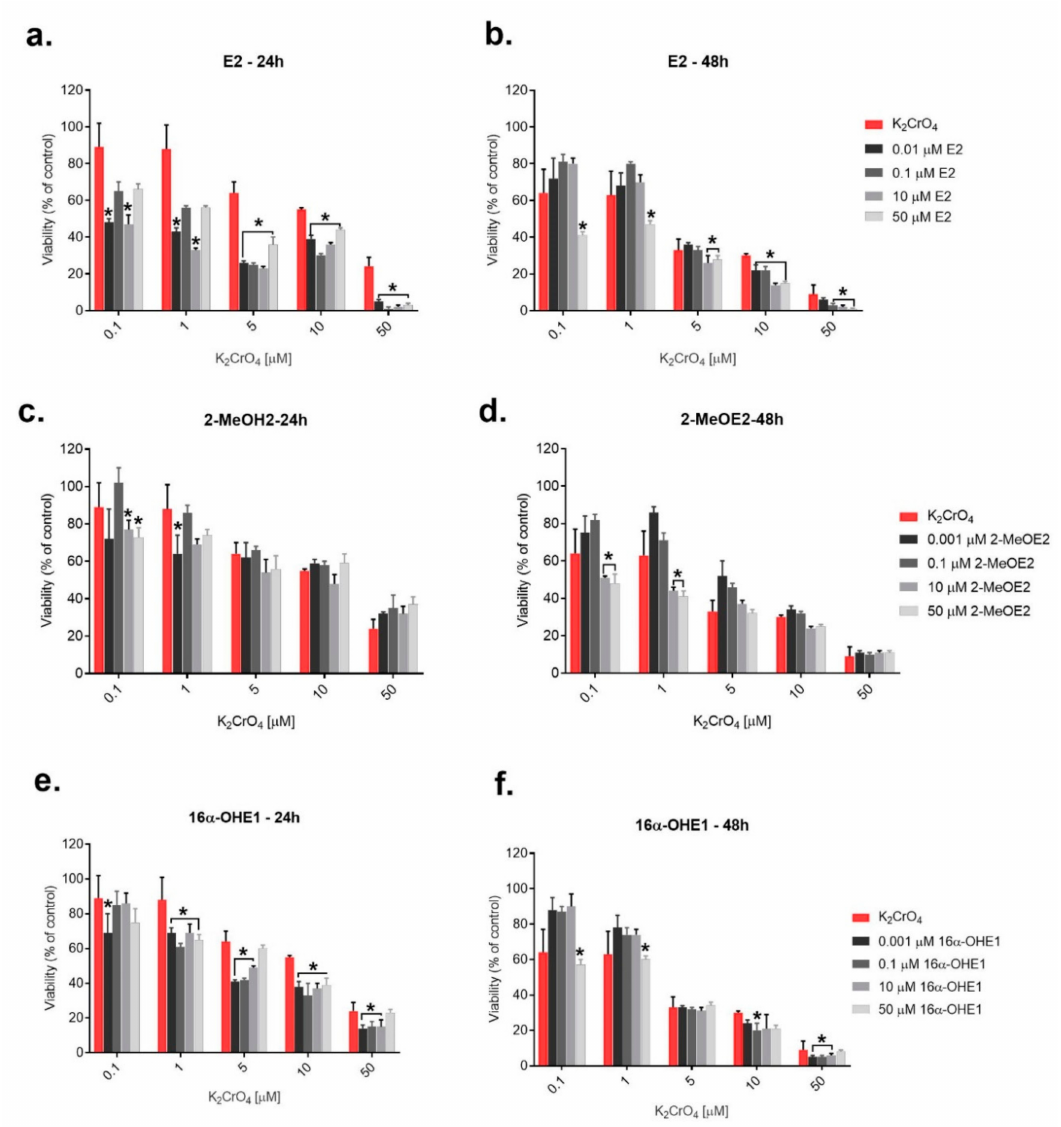
Figure 2. Changes in SKOV-3 viability after simultaneous e ff ect of both E2 and K 2 CrO 4 ( a , b ), 2-MeOE2 and K 2 CrO 4 ( c , d ), 16 α -OHE1 and K 2 CrO 4 ( e , f ), measured by MTT after 24 h and 48 h (* statistically significant, p <